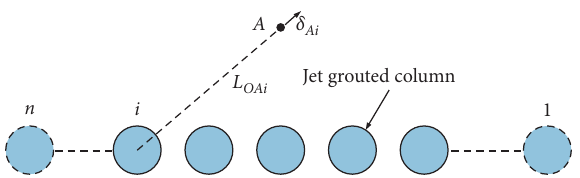
Figure 7: Illustration of ground displacements induced by in- stalling a row of columns (after